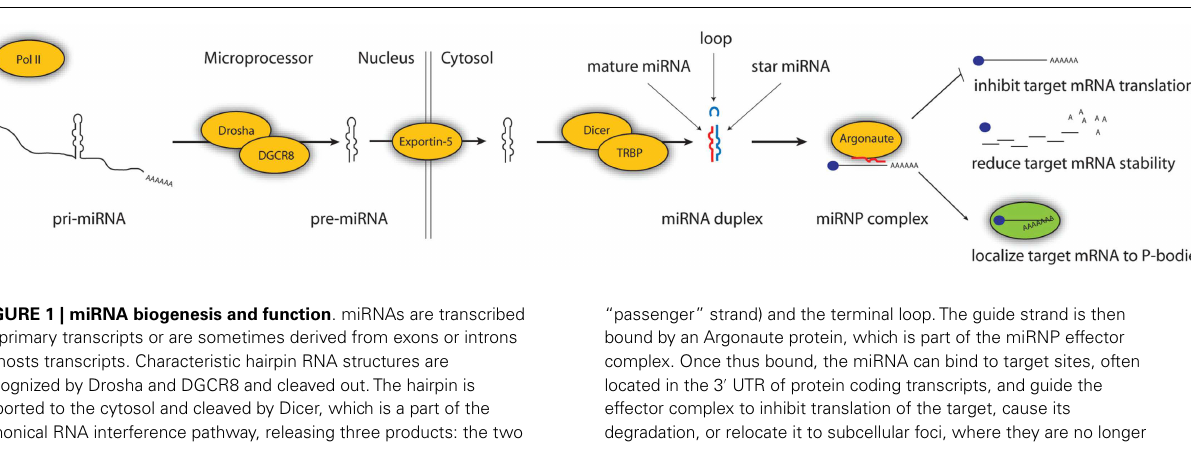
FIGURE 1 | miRNA biogenesis and function . miRNAs are transcribed as primary transcripts or are sometimes derived from exons or introns of hosts transcripts. Characteristic hairpin RNA structures are recognized by Drosha and DGCR8 and cleaved out.The hairpin is exported to the cytosol and cleaved by Dicer, which is a part of the canonical RNA interference pathway, releasing three products: the two miRNA strands (the “mature” or “guide” strand and the “star” or